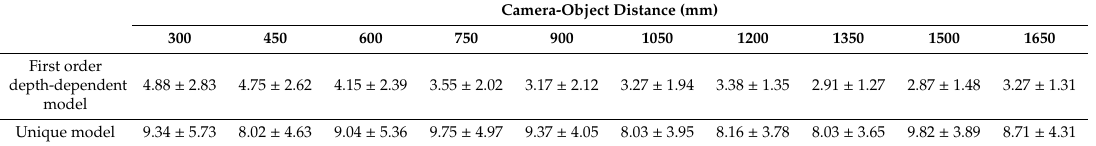
Table 3. Calibration error with 8 mm lens and non-parallel planes (mean and standard deviation) a